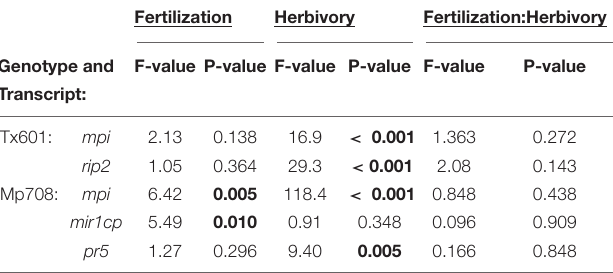
TABLE 3 | ANOVA table of maize transcripts and their expression as affected by fertilization and herbivory. Fertilization Herbivory